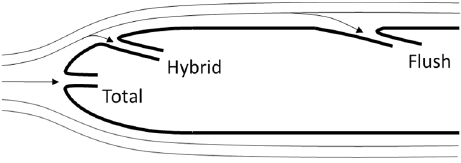
Figure 3. Submerged off-take types on a round leading-edge surface.